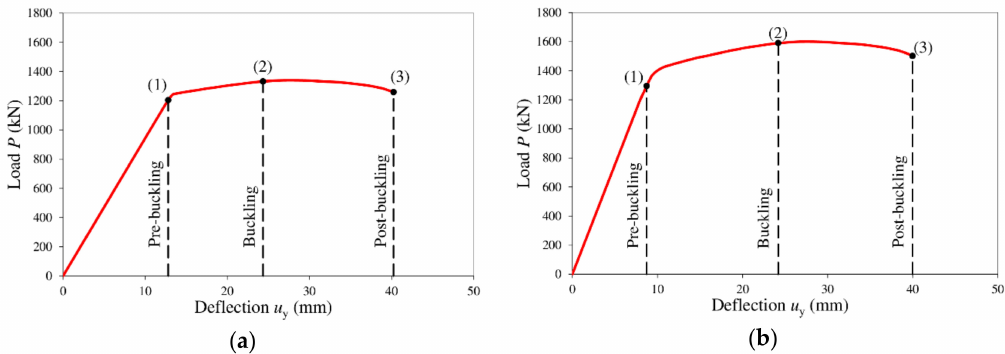
Figure 17. Static equilibrium paths determined in the numerical investigations: ( a ) steel beam; ( b ) beam bonded to a reinforced concrete